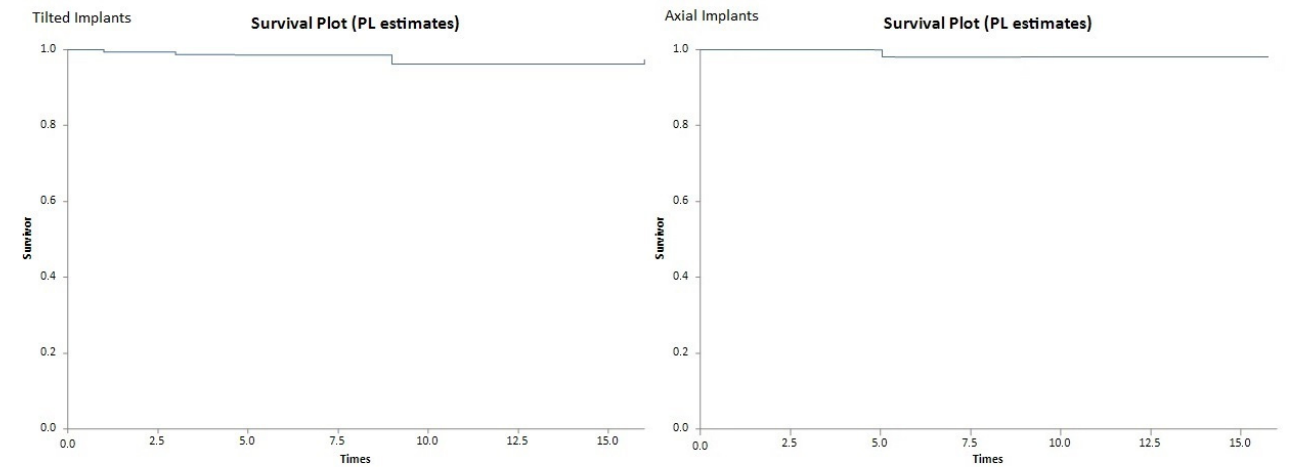
Figure 4. Kaplan–Mayer survival analysis charts for tilted and axial implants. Fifteen implants suffered from peri-implantitis, distributed between group A and B. Empirical data on plaque accumulation was obtained from the clinical folders.